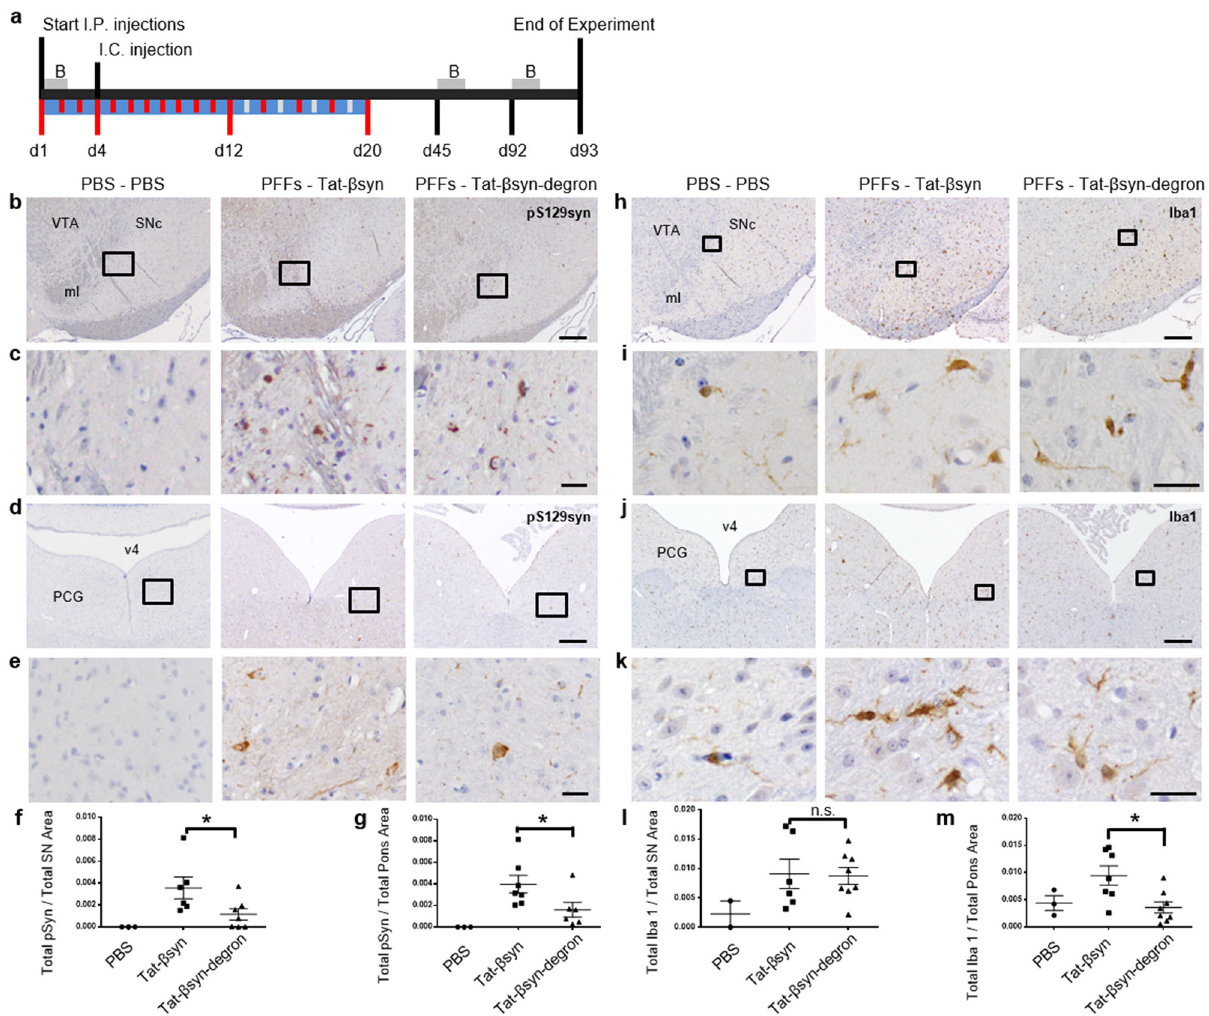
Fig. 5 Tat- β syn-degron protects against α -synuclein propagation in a mouse model of synucleinopathy. a The experimental timeline. M83 mice were injected i.c with PBS or PFFs and i.p. with PBS, Tat- β syn, or Tat- β syn-degron. B: behavioral tests. Vertical red lines: the days that the mice received i.p. injections. Vertical white lines: the days off i.p. injections. b , d Phosphorylated (pS129) α -synuclein immunostaining of coronal sections at the level of substantia nigra ( b ) and pons ( d ) from M83 mice. c , e Magni fi ed images expanded from boxes in b or d showing pS129 α -synuclein staining. f , g Histogram showing the total pS129 α -synuclein (Total pSyn) staining per area at the level of substantia nigra ( f , PBS: N = 3; Tat- β syn: N = 6; Tat- β syn-degron: N = 7; t = 2.235, d.f. = 11, P < 0.05) and pons ( g , PBS: N = 3; Tat- β syn: N = 7; Tat- β syn-degron: N = 6; t = 2.180, d.f. = 11, P = 0.05) quanti fi ed from panels ( b , d ). h , j Microglial Iba-1 immunostaining of coronal sections at the level of substantia nigra ( h ) and pons ( j ) from M83 mice. i , k Magni fi ed images expanded from boxes in h and j showing Iba-1 staining. l , m Histogram showing the total Iba-1 staining per area at the level of substantia nigra ( l , PBS: N = 2; Tat- β syn: N = 6; Tat- β syn-degron: N = 8; F (2,13) = 1.61, P = 0.238) and pons ( m , PBS: N = 3; Tat- β syn: N = 7; Tat- β syn-degron: N = 8; F (2,15) = 5.14, P < 0.05, Bonferroni post hoc test: Tat- β syn-degron vs. Tat- β syn: P < 0.05) quanti fi ed from panels ( h , I ). Data are presented as mean ± SEM. Statistical signi fi cance in f and g was determined by unpaired t test (because the PBS group did not have any pS129 α -synuclein staining and all the values were 0). Statistical signi fi cance in l and m was determined by one-way ANOVA, followed by Bonferroni post hoc test. * P ≤ 0.05 denotes the difference between the Tat- β syn group and the Tat- β syn-degron group. n.s. denotes not signi fi cant. ml medial lemniscus, PCG pontine central gray, SNc subtantia nigra pars compacta, v4 4th ventricle, VTA ventral tegmental area. Scale bar: 200 µ m in panels ( b , d , h , j ); 25 µ m in panels ( c , e , i , k ). Solid circles, squares and triangles represent individual data points in each